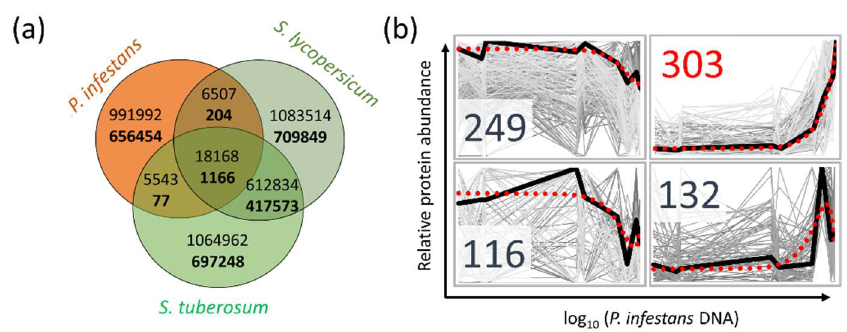
Figure 7. Elucidation of false-positive Phytophthora protein identifications. ( a ) Evolutionarily conserved peptide sequences in three model genomes digested by trypsin in silico. Numbers corresponding to low-stringency (maximum three miscleavages, 6–30 amino per peptide) and high-stringency criteria peptides (maximum one miscleavage, 8–25 amino acids per peptide) are represented in plain and bold font, respectively; ( b ) correlations between P. infestans DNA and protein relative abundances. Numbers indicate the size of the protein profile cluster. The mean profile and polynomial regression are represented by black and red curves, respectively. See Supplementary Tables S10 and S11 for details.